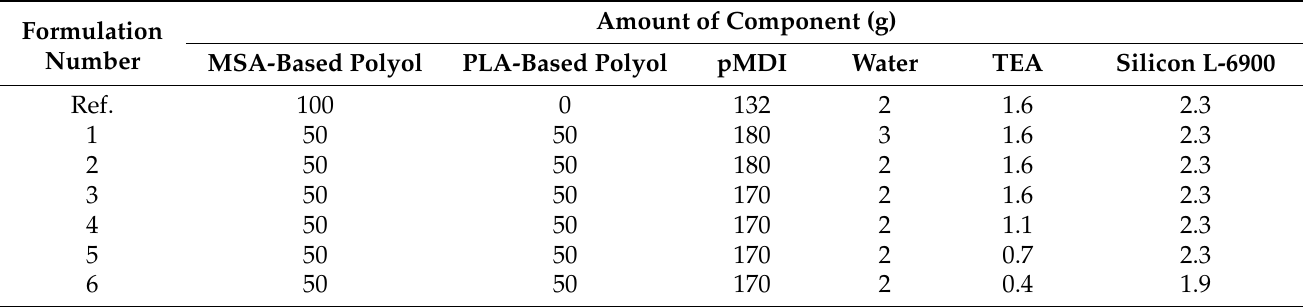
Table 10. Formulations of foams based on the mixture of MSA- and PLA-polyols.